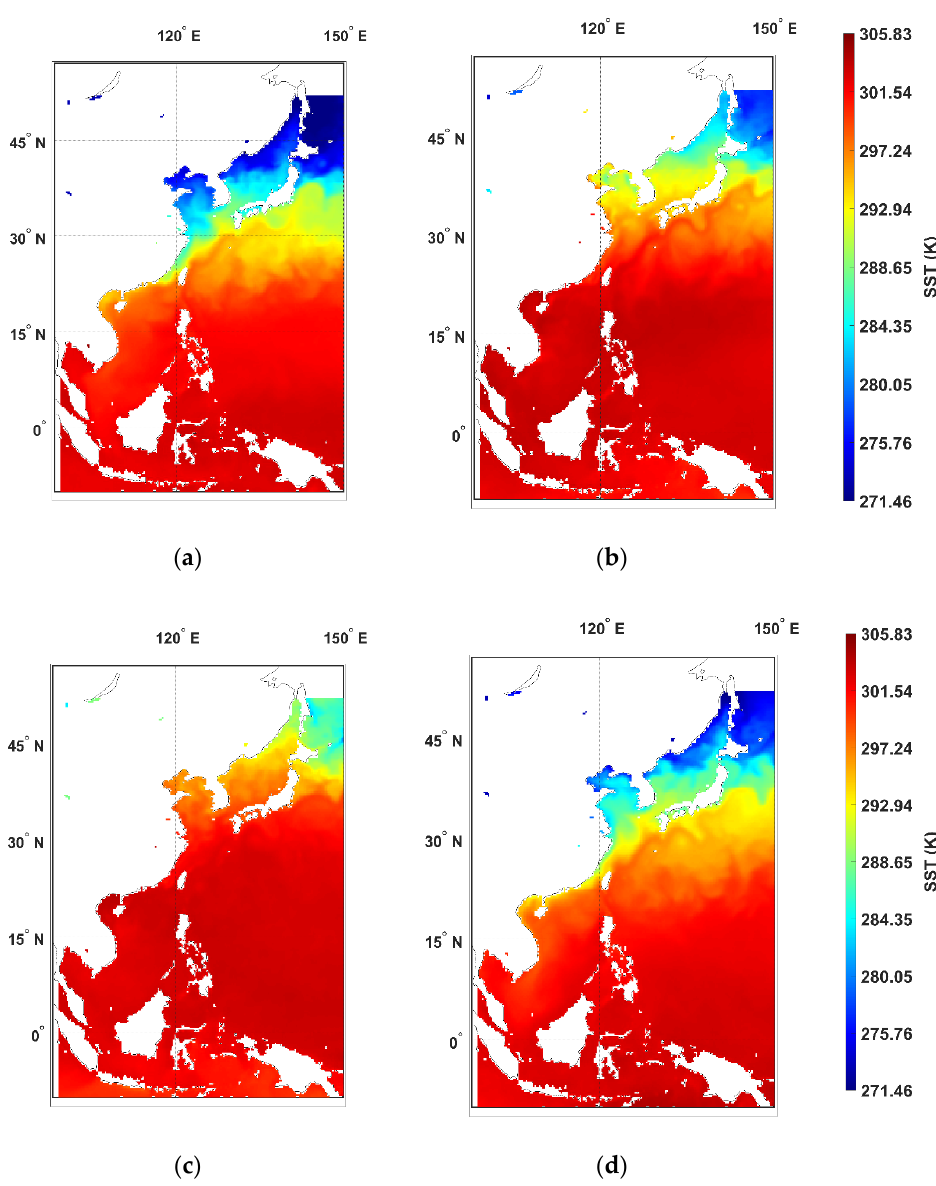
Figure 8. SST distribution of sea areas surrounding China in ( a ) March, ( b ) June, ( c ) September, and ( d ) December in 2021.